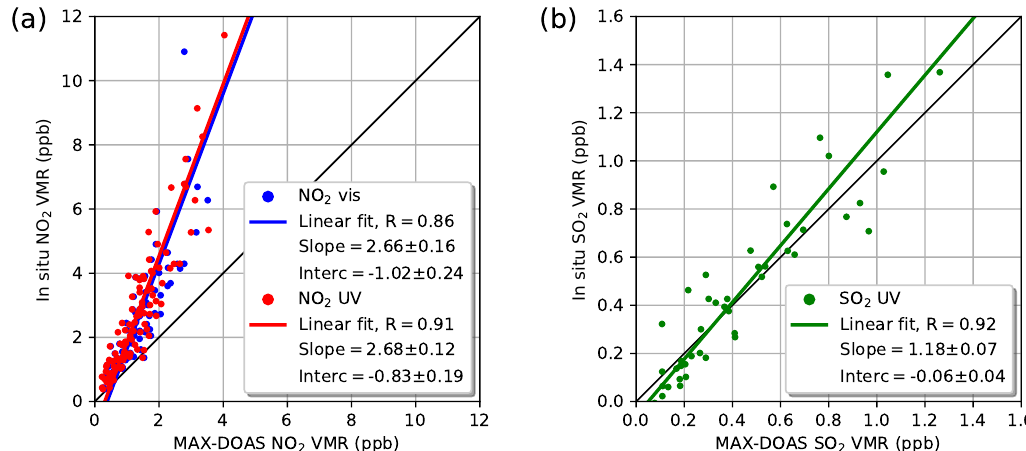
Figure 13. Scatter plot of (a) NO 2 VMR and (b) SO 2 VMR from MAX-DOAS vs. in situ. For NO 2 , daily means from summer 2014 are shown, and for SO 2 , daily means from summer 2013 are shown. For the MAX-DOAS instrument, to get a better statistic, all measurements in all azimuth viewing directions have been averaged. For the in situ instrument, the mean of all measurements during the daily MAX- DOAS measurement periods (sunrise till sunset) has been taken. The linear fits were calculated with orthogonal distance regression (Deming regression); parameters are shown in the figures.